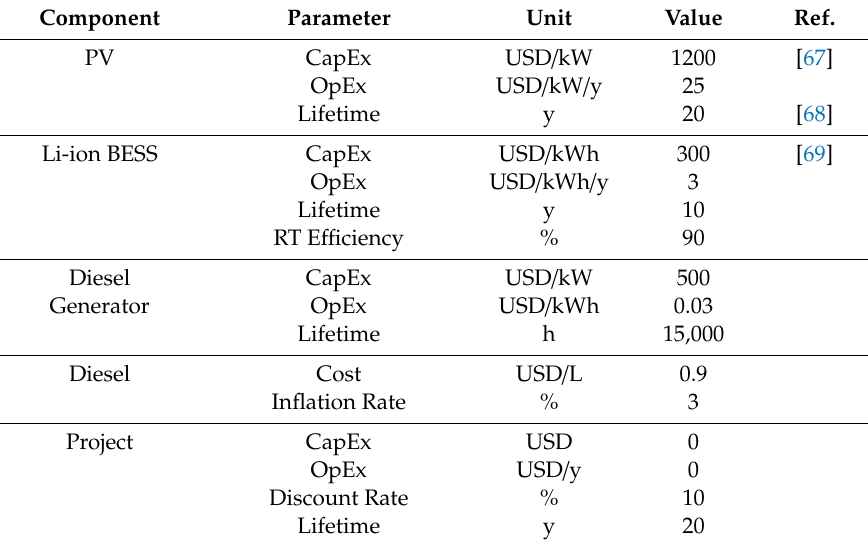
Table A1. Techno-economic parameters of energy components.